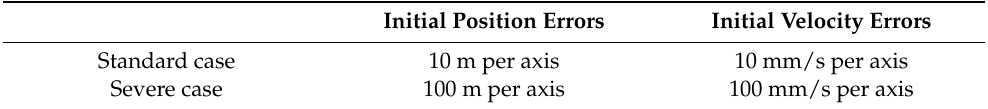
Table 3. The STDs of the insertion errors of the simulated